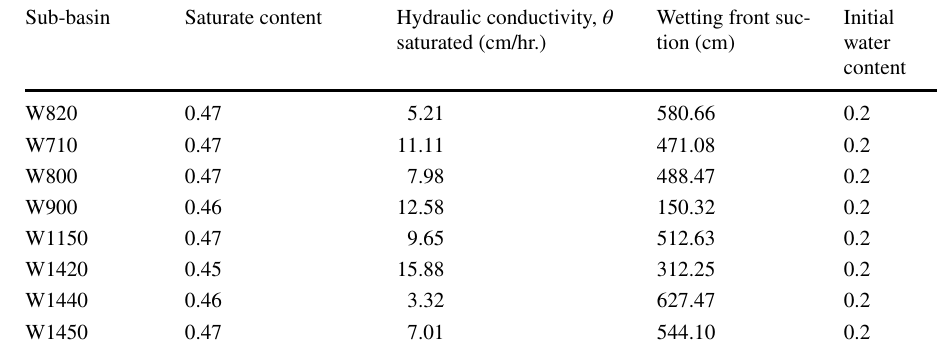
Table 5 Green Ampt Initial Model Parameters